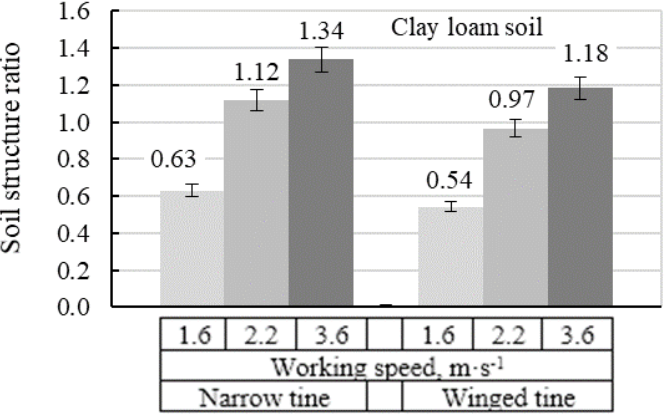
Figure 8. Dependence of soil structure fraction ratio on speed and tine types on clay loam.